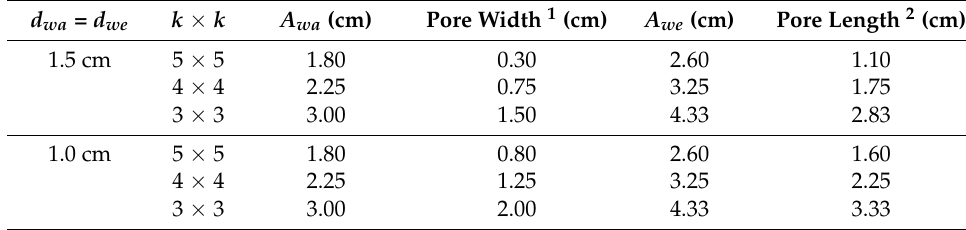
Table 3. Parameters of designed structures.